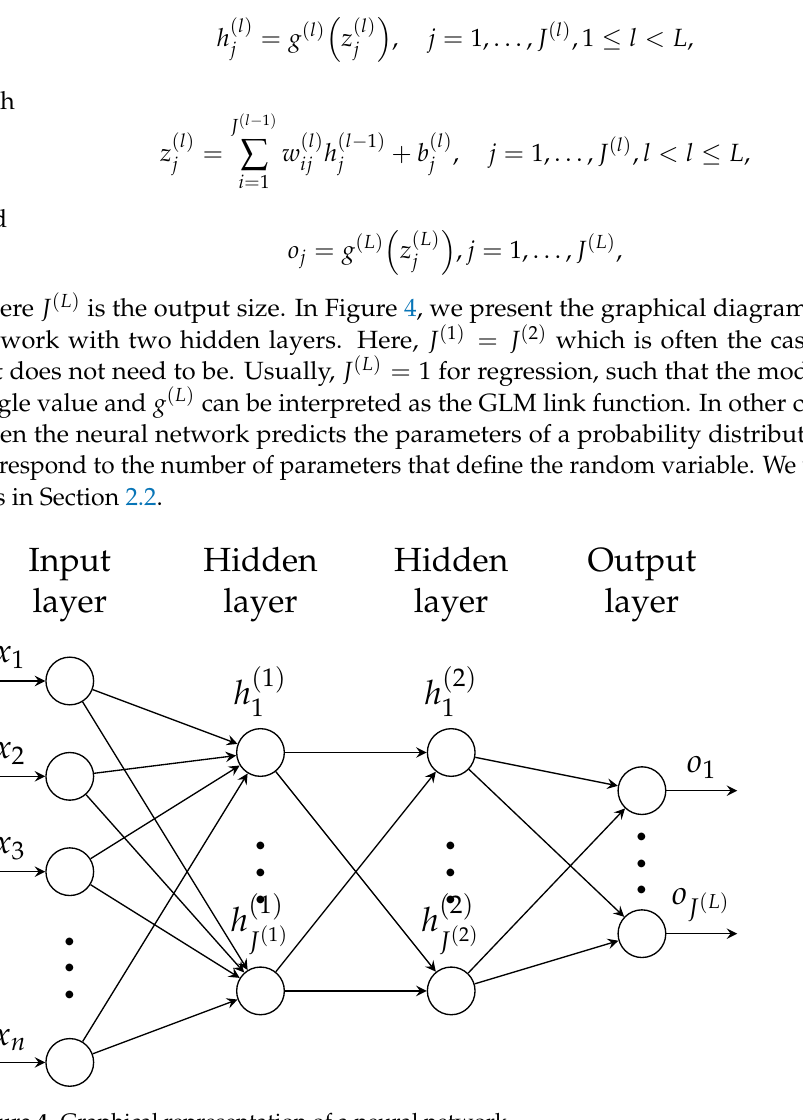
Figure 4. Graphical representation of a neural network.